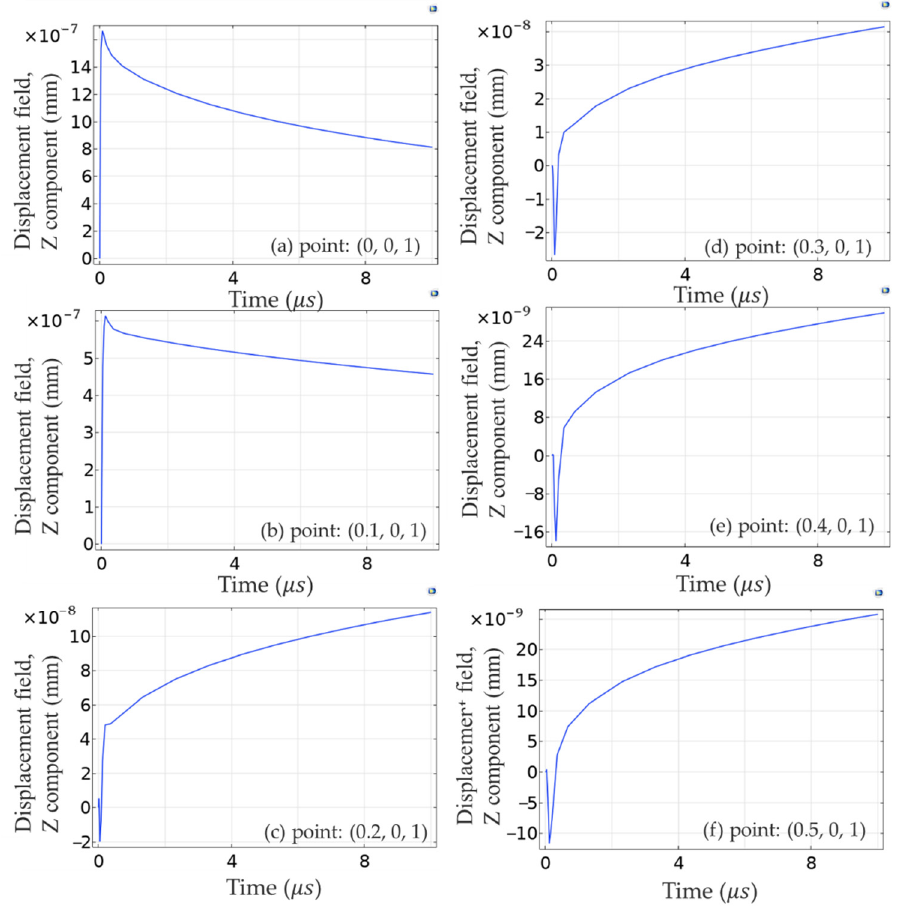
Figure 7. The displacement changes vs. time in different points on the silicon surface on model 2.